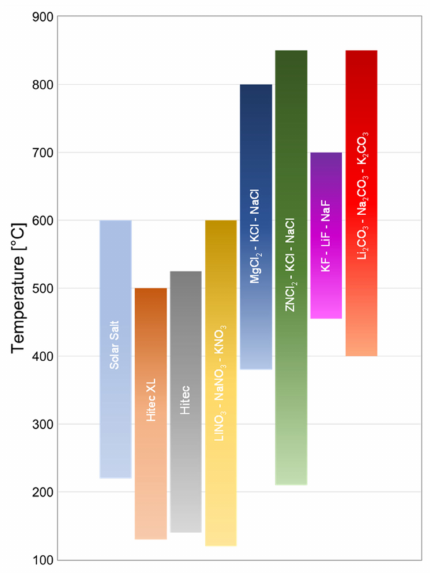
Figure 11. Melting point and maximum operative temperature of commercial molten salts (data reported from